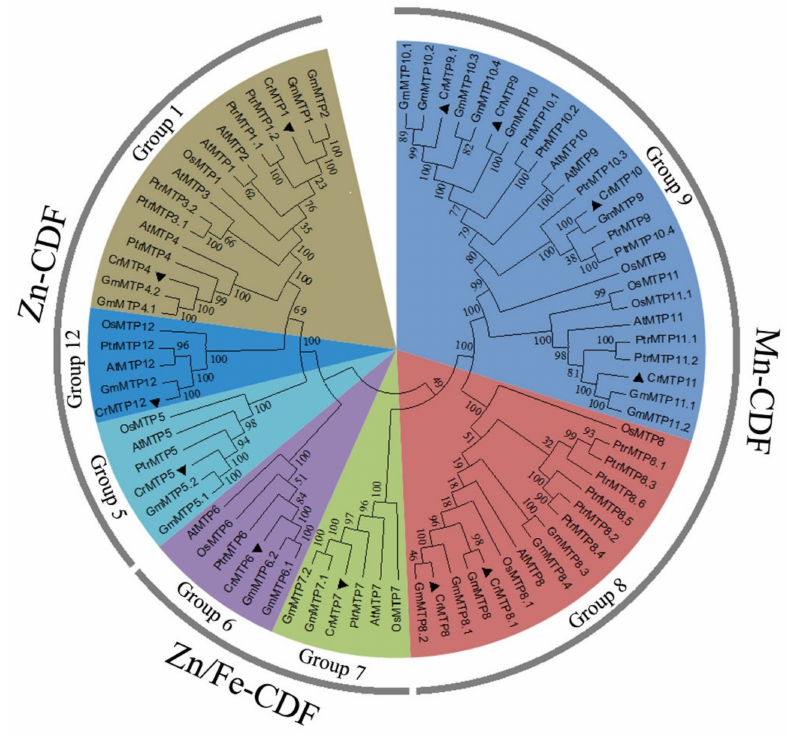
Figure 3. Phylogenetic tree of CrMTPs from C. rosea , Arabidopsis, soybean, rice, and poplar. The neighbor-joining (NJ) tree was constructed using Clustal W and MEGA 6.0 software with 1000 bootstrap replicates.